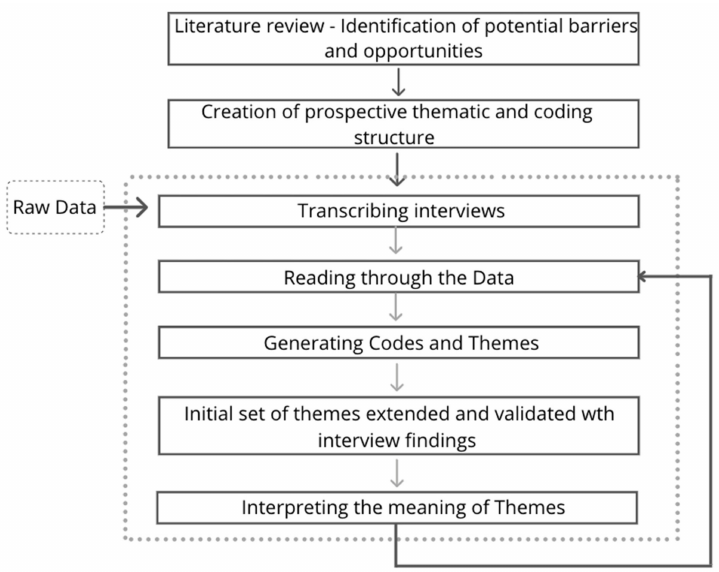
Figure 2. Data analysis steps. Adapted from